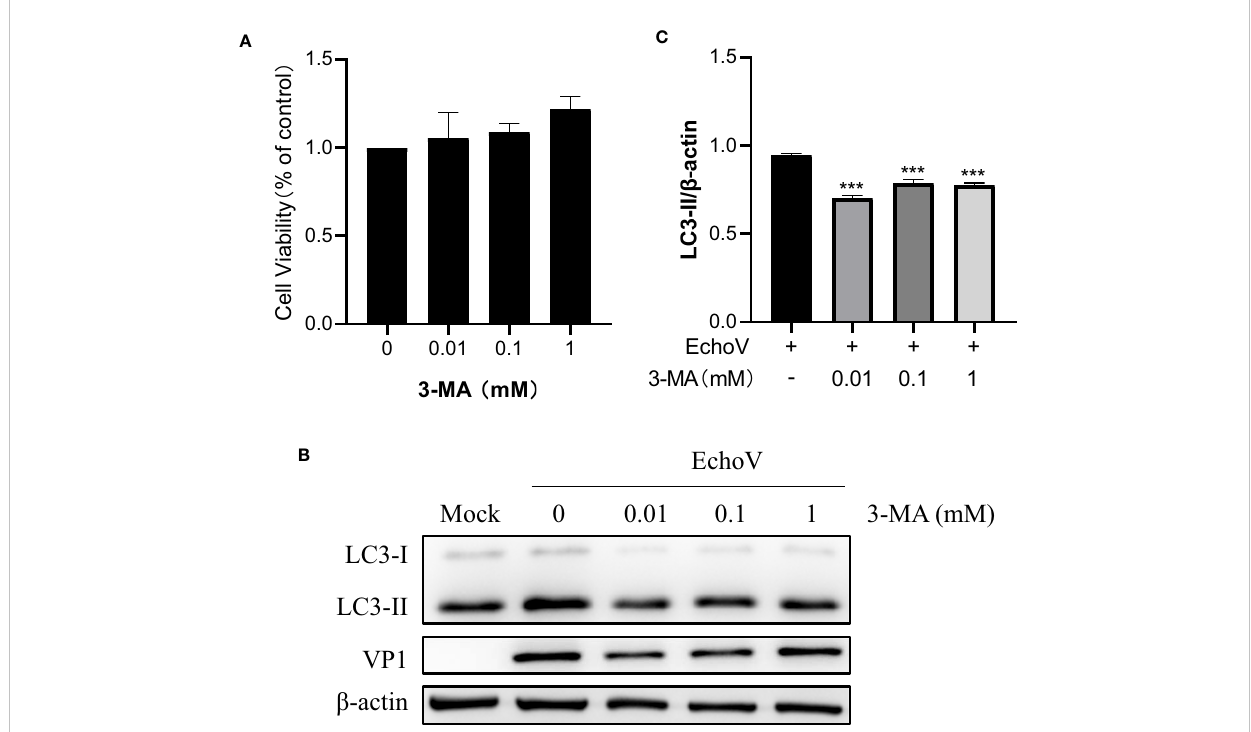
FIGURE 7 Inhibition of Autophagy inhibits EchoV replication. RD cells were pre-untreated or pre-treated with 3-MA at indicated concentrations for 2 h, followed by infected (EchoV) or not (Mock) with echovirus 11 at 0.1 MOI for 1.5 h. At 16 h post-infection, cells were then harvested. (A) Cell counting kit-8 (CCK8) assay was performed to examine the cytotoxicity of 3-MA to RD cells. (B) Intracellular LC3 and viral VP1 proteins were detected via western blotting. b -actin served as a loading control. This result is representative of three independent experiments. The relative band intensities of detected proteins were calculated using ImageJ from NIH, and the result was represented as the ratio of LC3-II to b -actin (C) . A one-way ANOVA was used to determine statistically signi fi cant differences in multiple comparisons. *** P